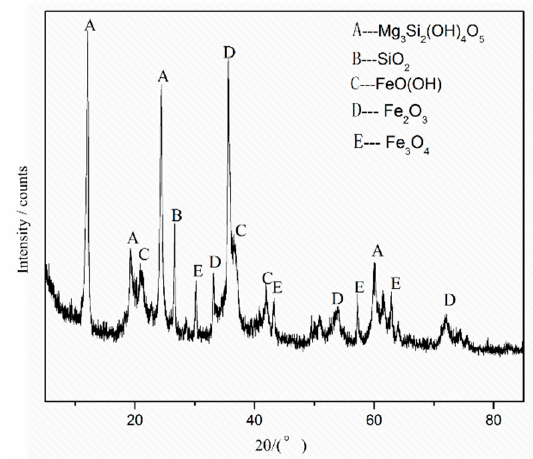
Figure 1. XRD pattern of the laterite sample.